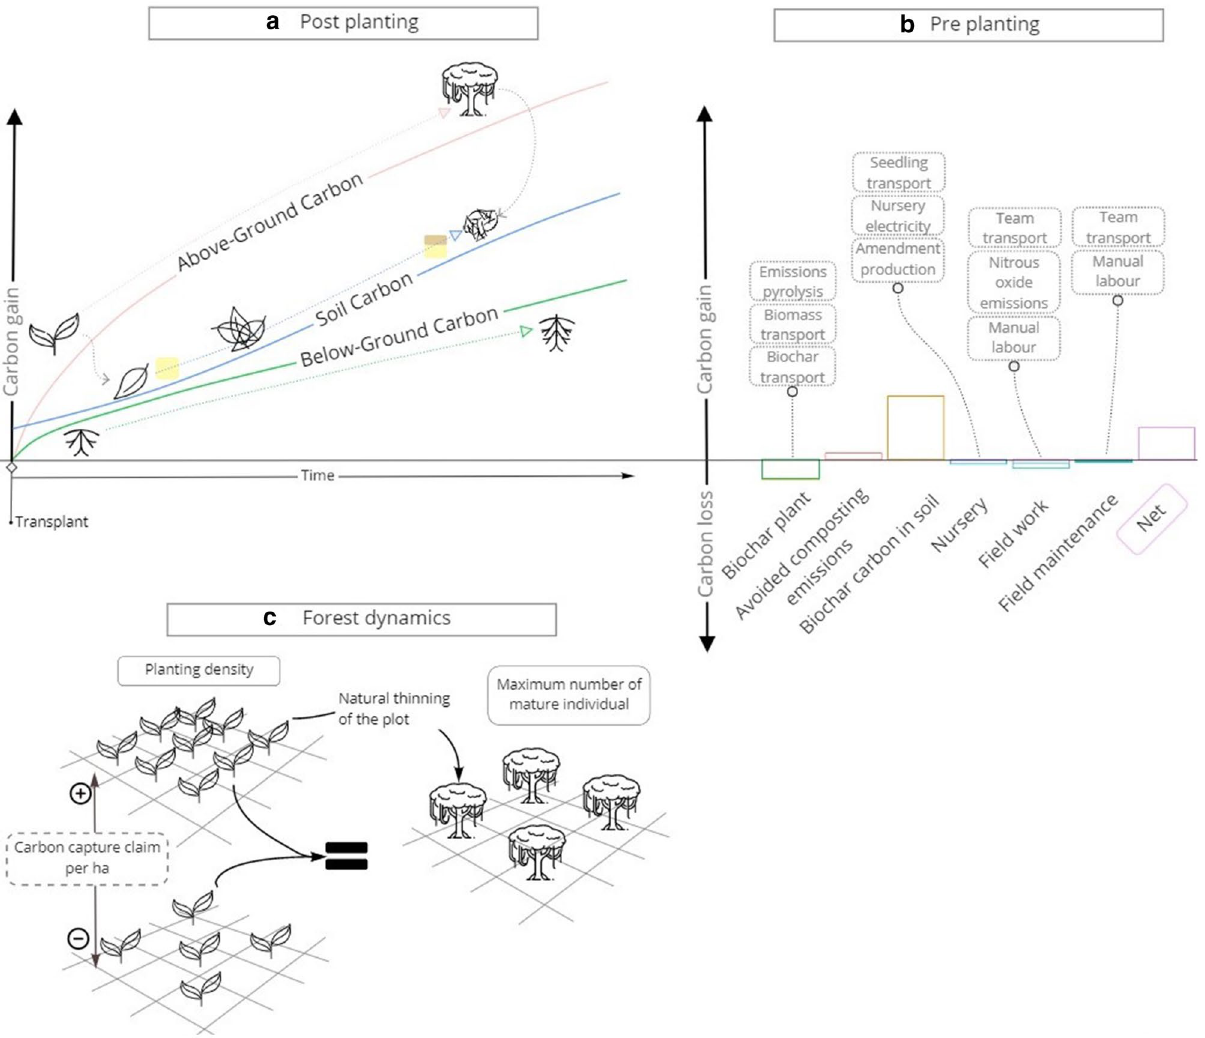
Figure 1. Descriptive schematic figure of the processes and stocks considered. ( a ) Vegetation and soil C stocks. ( b ) Processes included in the LCA and their relative impact. c effect of the planting